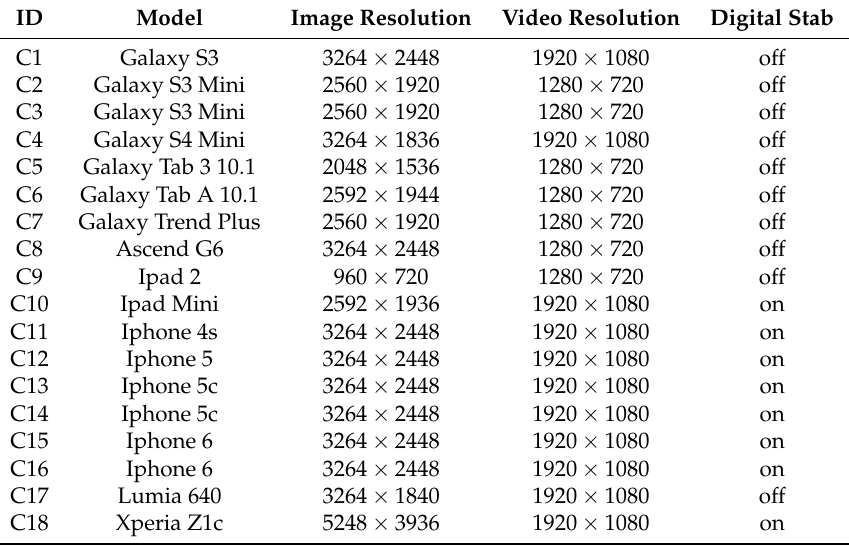
Table 1. Considered devices with their default resolution settings for image and video